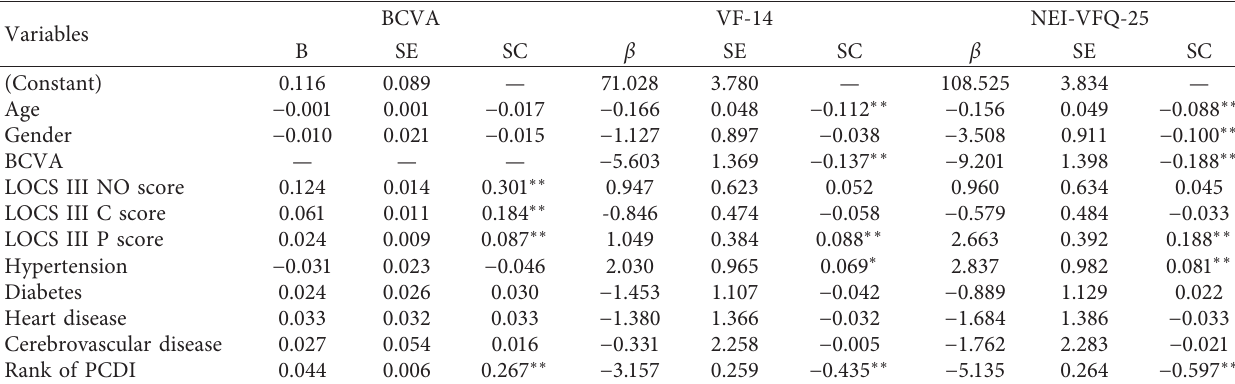
Figure 3: Bar graphs showing distributions of LOCS III scores among levels of investment in the energy industry. (a) Distribution of LOCS III NO score across levels of investment; (b) distribution of LOCS III C score across levels of investment; (c) distribution of LOCS III P score across levels of investment. VF-14, Visual Function Index-14; NEI-VFQ-25, 25-item National Eye Institute Visual Functioning Ques- tionnaire; BCVA, best-corrected visual acuity; LOCS III, Lens Opacities Classification System III; NO, nuclear opalescence; C, cortical; P, posterior Table 3: Multiple linear regression model for BCVA, VF-14, and NEI-VFQ-25.